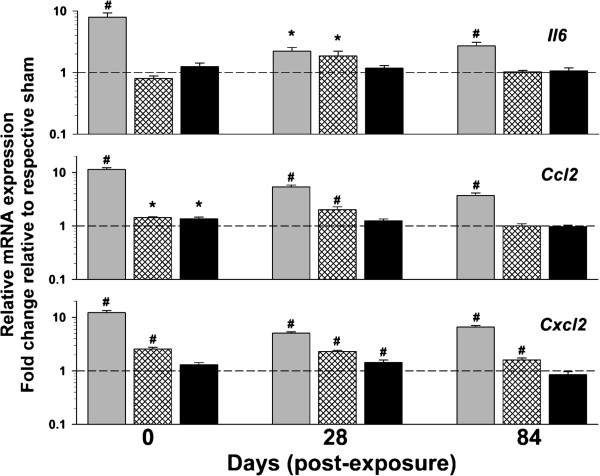
Effect of multi-walled carbon nanotube (MWCNT) inhalation on pulmonary inflammatory gene expression at different time points after exposure. Interleukin 6 (Il6), chemokine (C-C motif) ligand 2 (Ccl2; also referred to as monocyte chemotactic protein-1), and chemokine (C-X-C motif) ligand 2 (Cxcl2; also referred to as macrophage inflammatory protein 2-alpha) were measured. Data are expressed as percent (%) change from respective sham (dashed line – 100%). Data presented as high dose (gray bars), medium dose (pattern), and low dose (black bars). *p<0.05 vs. respective sham; #p<0.05 vs. other MWCNT depositions for a given time point only.